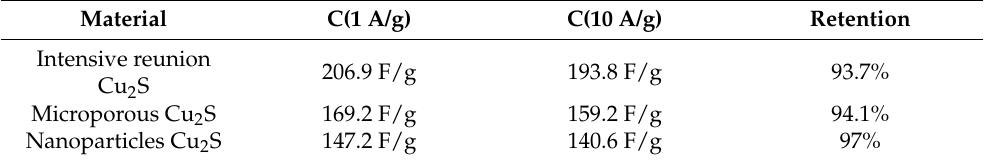
Table 2. Specific capacitance and capacitance capability of cuprous sulfide with different morphologies.